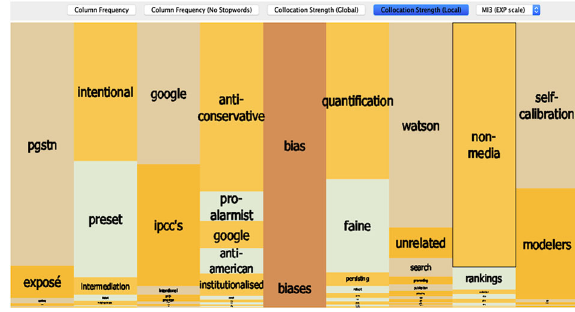
Fig. 2 Mosaic visualization of bias/-es in CSBC-CON (34 lines). Collocation strength: Local, MI3 (EXP Scale).